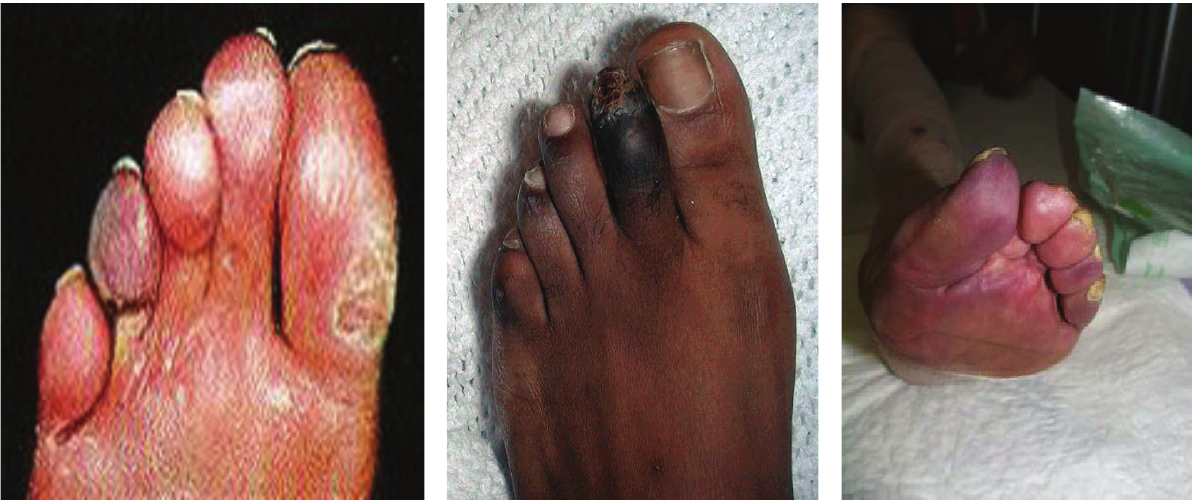
Figure 3: Ischemic diabetic foot.